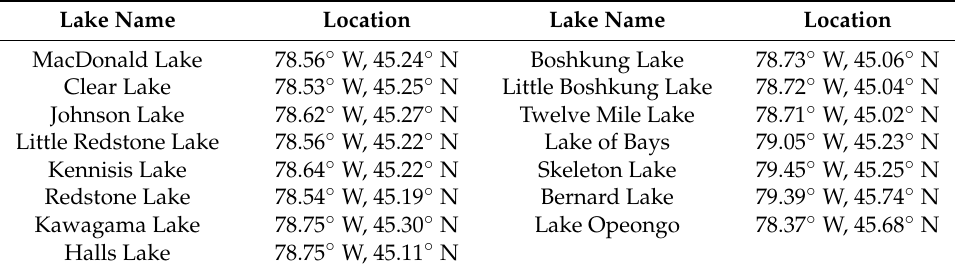
Table 1. Study lakes in Central Ontario and the associated spatial